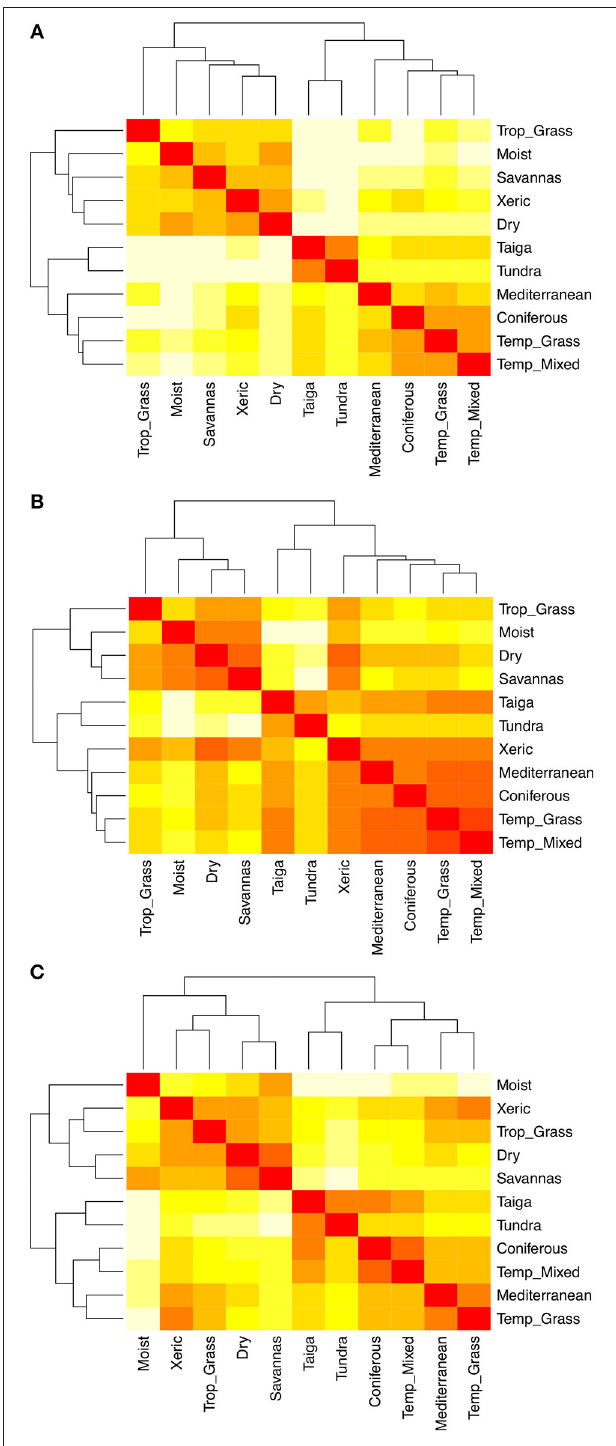
FIGURE 5 | (A) Pairwise dissimilarity in species composition among biomes. (B) Pairwise dissimilarity in trait hypervolumes (1-Sørensen similarity) among biomes using the total number of species. (C) Pairwise dissimilarity in trait hypervolumes (1-Sørensen similarity) among biomes using only those species that are considered as functionally similar and widespread. The lighter the cell the greater the